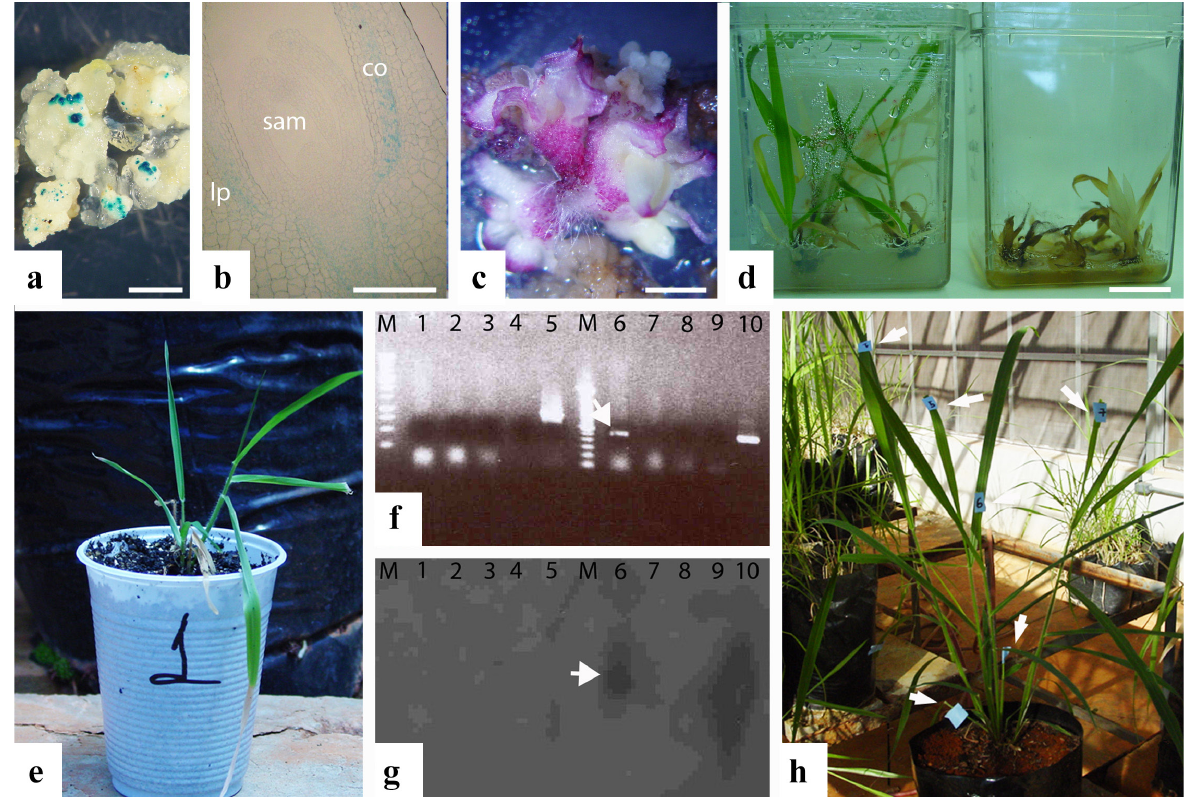
Figure 2 - Transformation of Brachiaria brizantha cv. Marandu embryogenic calluses via biolistics, and molecular analyses of putative transformed plants: ( a ) gus expression in embryogenic calluses induced for 30 d on M1.3 medium and bombarded with pAHUG; ( b ) longitudinal section of a somatic embryo developed from embryogenic callus bombarded with pAHUG, and cultivated in regeneration medium, showing gus expression in the coleoptile and leaf primordium, and absence of expression in the shoot apical meristem; ( c ) germinating somatic embryos in MS3 medium with hygromycin showing anthocyanin pigments; ( d ) hygromycin resistant plantlets (left) and untransformed control (right) in medium containing 20 mg/L hygromycin; ( e ) acclimatized hygromycin resistant plantlet; ( f ) detection of gus (1-5) and hptII (6-10), by PCR; pAHUG (5 and 10) as positive control; putative transformed plants (1-4 and 6-9); column 6 is a plant showing an amplified band corresponding to hptII (arrow), M = marker; ( g ) DNA gel blot with positive signal for hptII in column 6 (arrow); ( h ) two-month-old plant, arrow indicate sampling areas for PCR. co = coleoptile; lp = leaf primordium; sam = shoot apical meristem; pe = proembryos. Bars: ( e ) 1 cm; ( f ) 0.2 mm; ( g , h ) 2